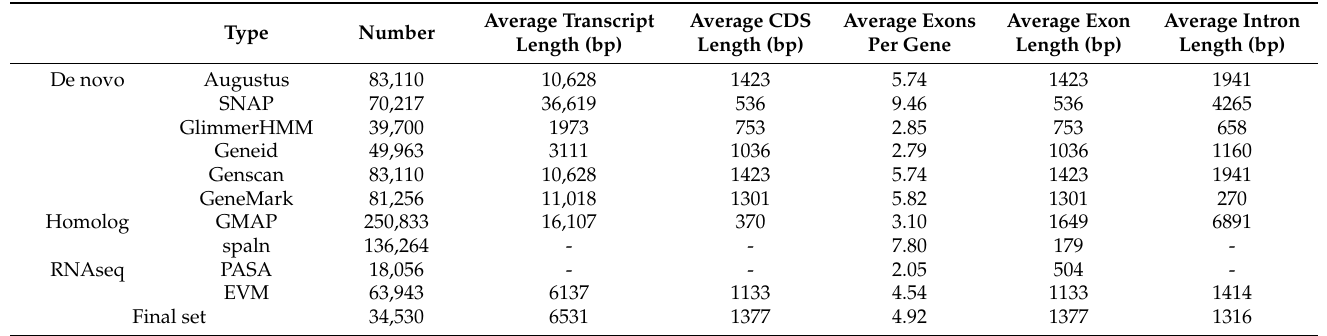
Table 6. Statistical gene structure prediction for the blue mussel M. chilensis genome.